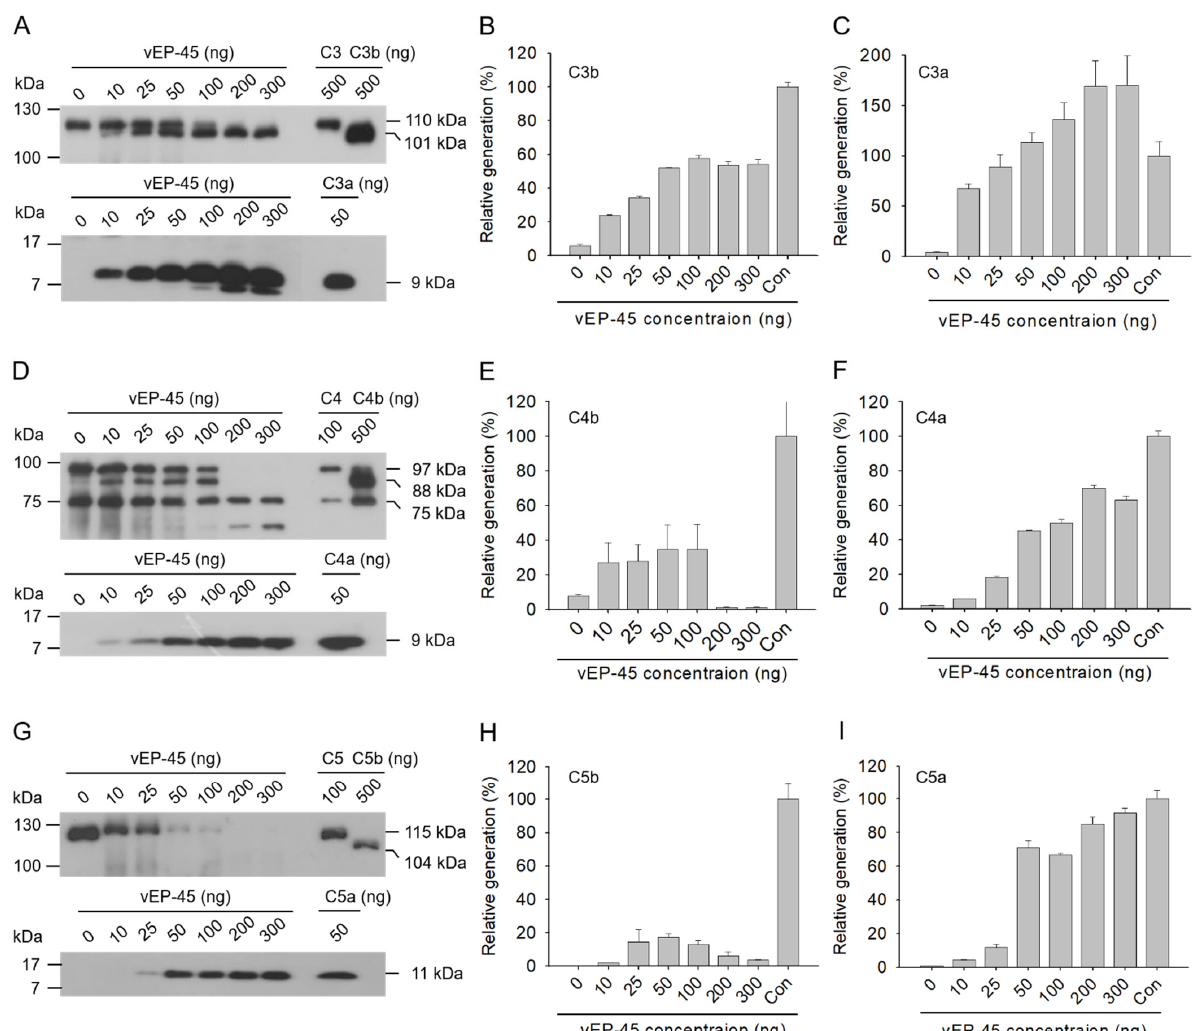
Figure 2. Cleavage of human complement proteins by vEP ‐ 45 as detected with Western blotting. ( A , D , G ) Human com ‐ plement protein C3 (1 μ g), C4 (0.5 μ g), or C5 (0.5 μ g) was incubated with vEP ‐ 45 (10, 25, 50, 100, 200, or 300 ng) for 3 min at 37 °C. Proteins from each sample were separated by SDS ‐ PAGE; Western blotting was performed using anti ‐ C3 anti ‐ body ( A upper panel), anti ‐ C3a antibody ( A lower panel), anti ‐ C4 antibody ( D upper panel), anti ‐ C4a antibody ( D lower panel), anti ‐ C5 antibody ( G upper panel), or anti ‐ C5a antibody ( G lower panel). The histograms show the production of ( B ) C3b α′ chain, ( C ) C3a, ( E ) C4b α′ chain, ( F ) C4a, ( H ) C5b α′ chain, and ( I ) C5a upon treatment with different concen ‐ trations of vEP ‐ 45, in which the values obtained using control (Con; only C3b, C3a, C4b, C4a, C5b, and C5a) were re ‐ garded as 100%. The uncropped Western blot images can be found in Figure S2.